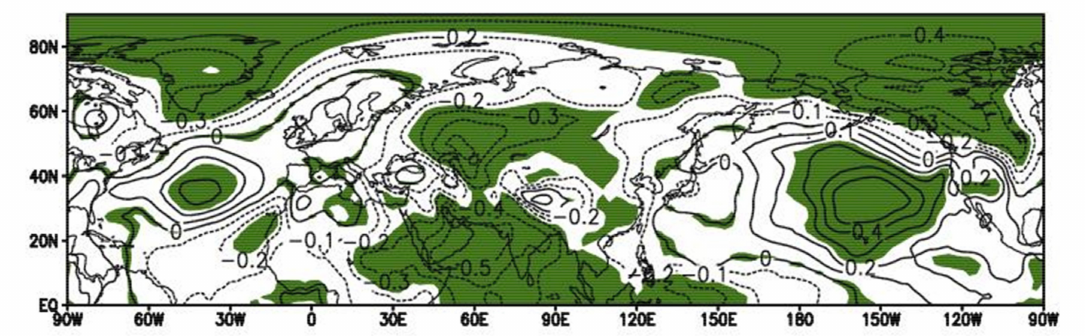
Figure 6. The spatial pattern of correlation between standardized JJAS area-averaged central India precipitation anomaly index and JJAS standardized global mean sea-level pressure anomalies for the period 1951–2000. Statistically significant (90%) regions are